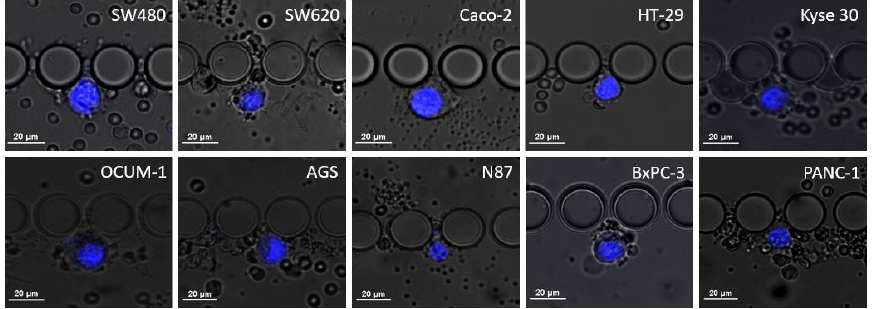
Figure 2. Microscopic images of the different cell lines when trapped inside the RUBYchip™ obtained after spiking experiments and stained with DAPI. The images were acquired using a 20× objective and used to calculate average cell dimensions and study cell morphology.